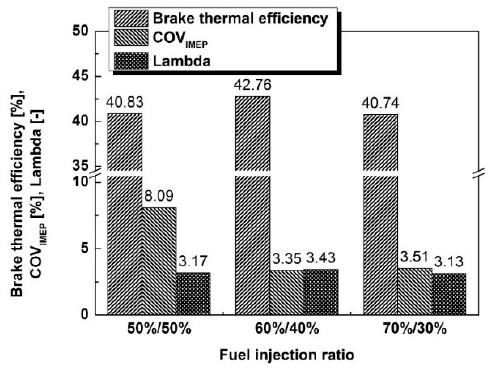
Figure 6. The comparison of brake thermal efficiency, combustion stability, and excess air ratio (Lambda) for the fuel injection ratios of 50%/50%, 60%/40%, and 70%/30% with the optimized first fuel injection timing and SA timing of 27 CAD BTDC at 1600 rpm and BMEP of 0.24 MPa.